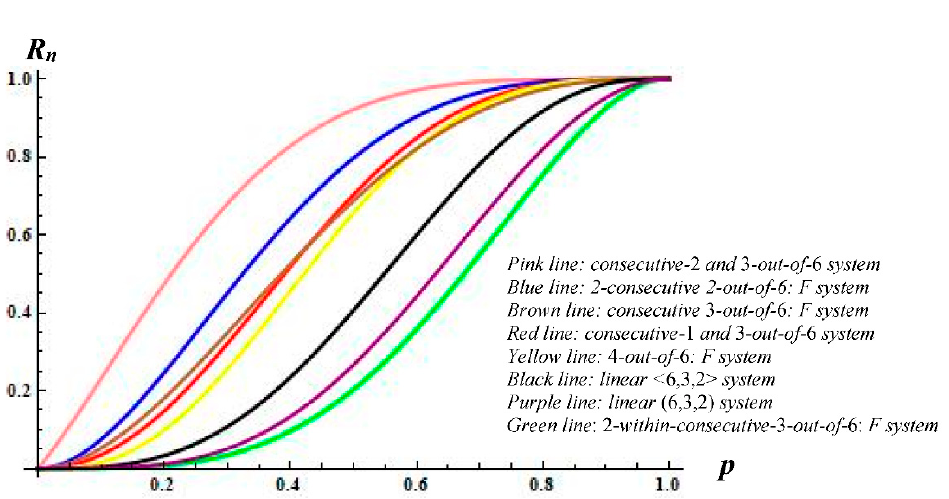
Figure 4. The reliability polynomial of several consecutive-type systems of order n = 6.